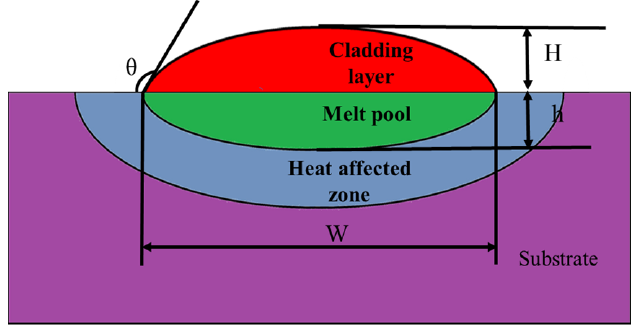
Figure 3. Typical cross-section of single cladding.